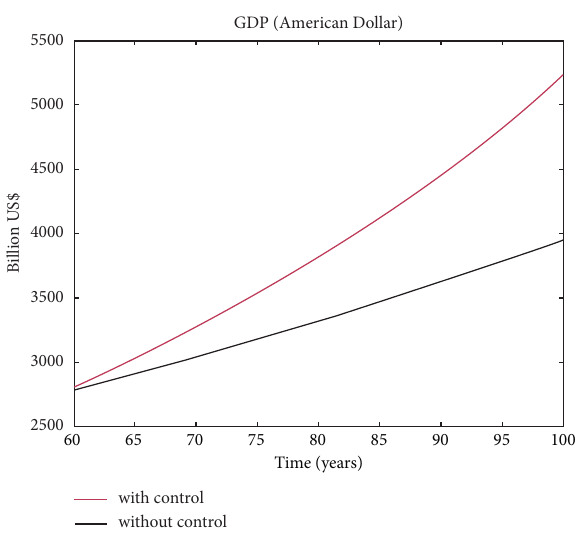
Figure 6: Comparison of GDP with and without